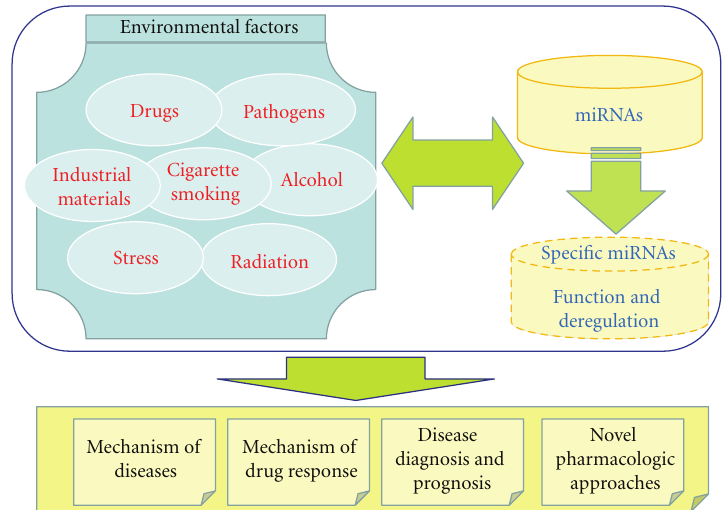
Figure 1: Significant roles of miRNAs-EFs